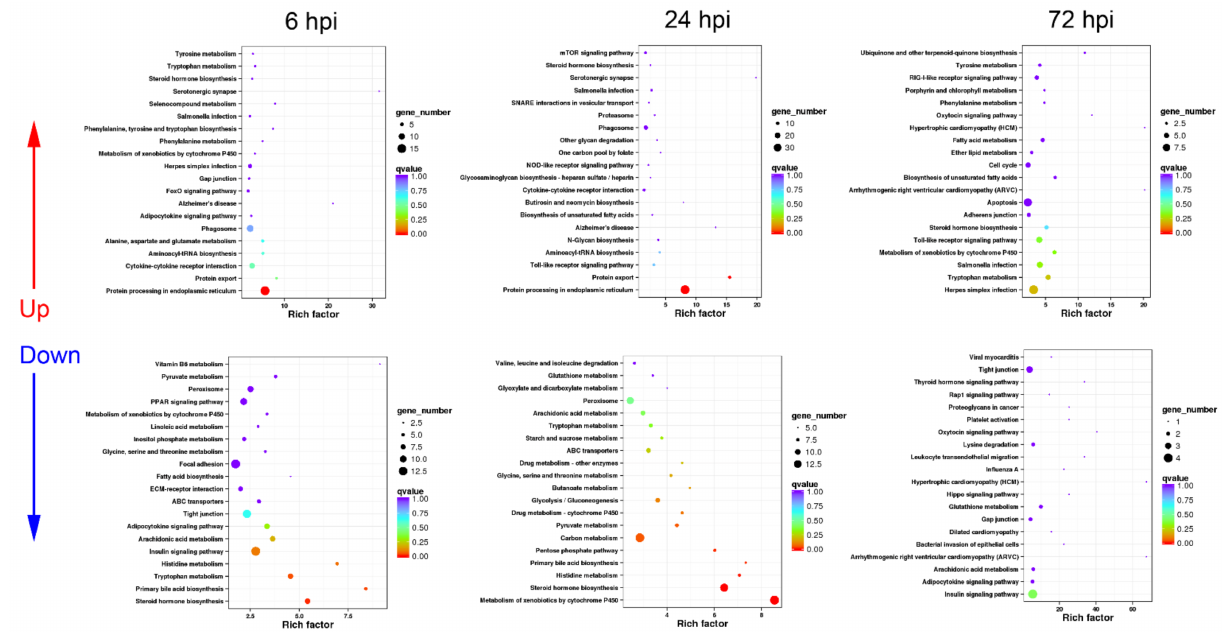
Figure 3. KEGG enrichment analysis in AL group turtles at different time periods. The top 20 KEGG pathways are presented here in the form of scatterplots to show the up-regulated and down-regulated DEGs enriched in livers from active subgroup turtles at 6, 12, and 72 hpi. The enrichment factor is the ratio between the DEG number and the number of all genes in a certain gene enrichment term. The sizes of the dots on these plots denote the number of DEGs, while colors correspond to the q value